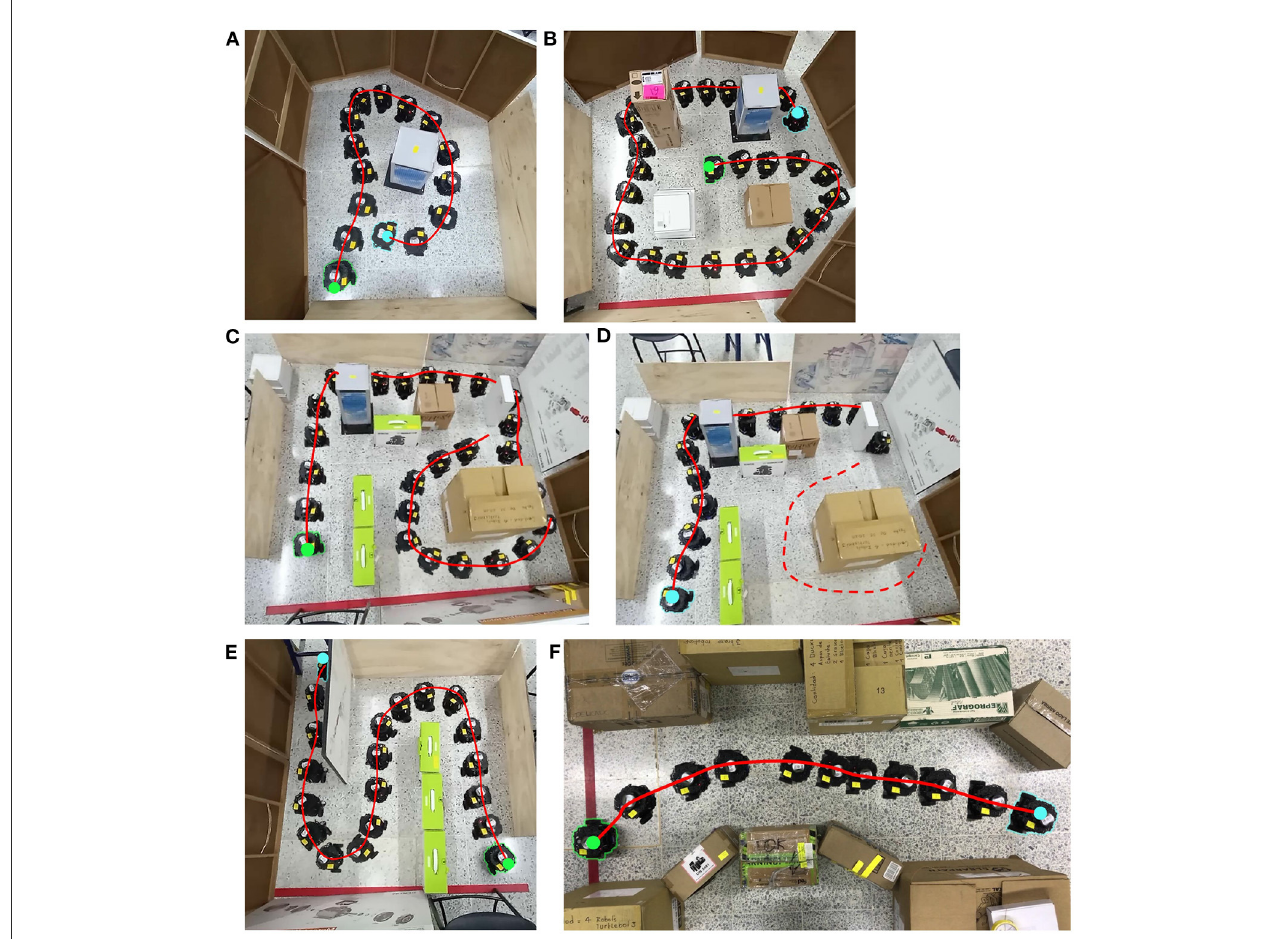
FIGURE12 Implementation environment results. The path made by the automaton was drawn with red lines in each type of environment. Green circles are initial positions and blue circles are final positions. (A) Loop. (B) Cross. (C, D) Traditional maze part 1 and part 2, respectively. (E) Zigzag. (F) Simple maze. There one can be observed how the automaton completed the (A, E, F) environments successfully. In the (B) environment the automaton’s performance started in the middle of the cross-environment and finished doing circles around the environment. In the (C, D) environments, there can be observed how the automaton’s trajectory finishes at its starting